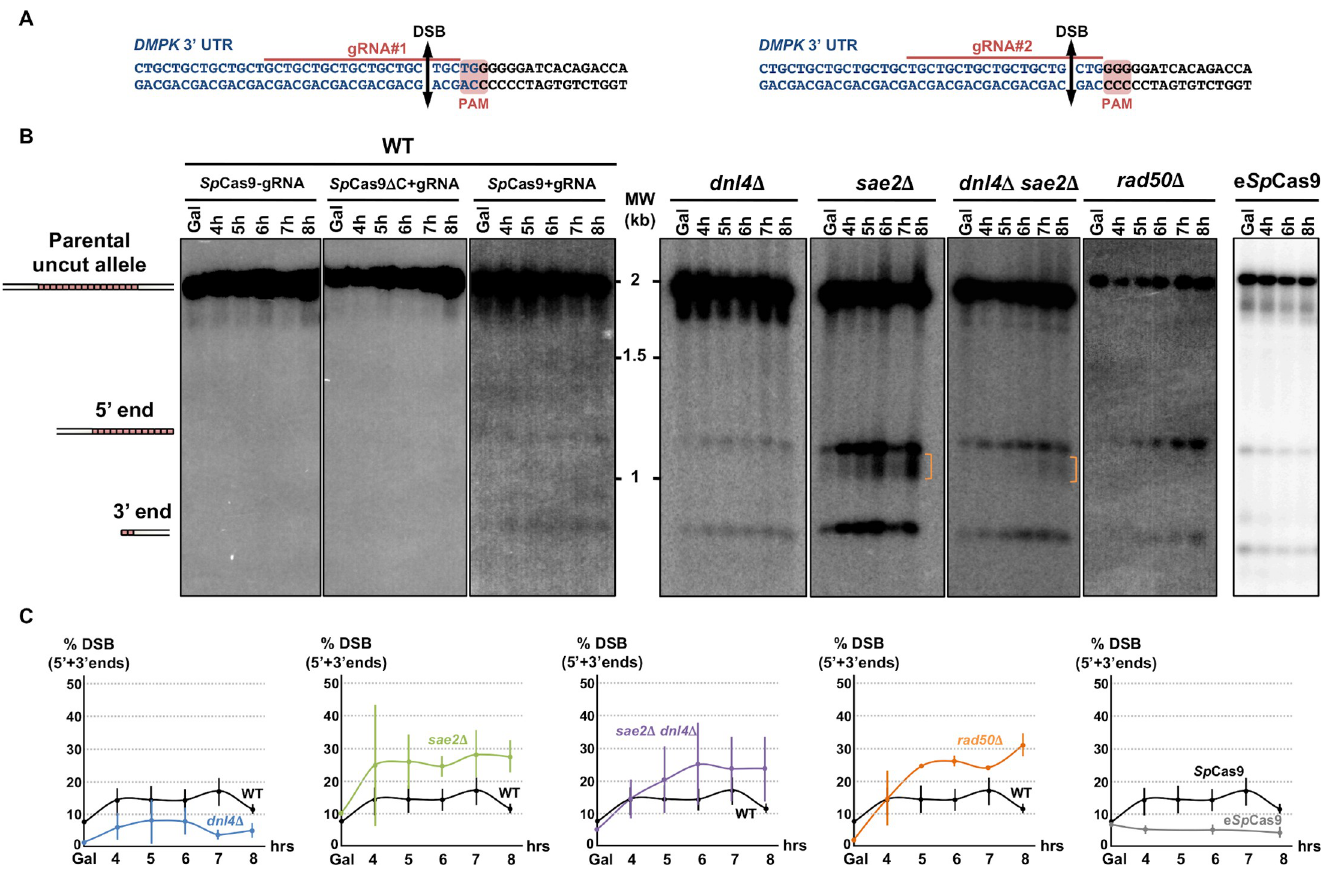
Fig 1. Sp Cas9 and e Sp Cas9 DSB induction in wild type and mutant strains. A: Sequence of the SUP4 ::(CTG)n locus. The CTG trinucleotide repeat tract comes from a human DM1 patient and is shown in blue. The flanking non-repeated DNA is in black. For each guide RNA, the PAM, the gRNA sequence as well as the expected DSB site are indicated. B : Southern blots of yeast strains during time courses. Lanes labeled Sp Cas9-gRNA and Sp Cas9 Δ Cter+gRNA are control strains in which no DSB was visible. In the strain expressing both Sp Cas9 and the gRNA, two bands are visible in addition to the parental allele (1966 bp). One band corresponds to the 3’ end of the DSB containing a small number of triplets (821 bp), the other one corresponds to the 5’ end of the DSB containing most of the repeat tract (1145 bp). C: Quantification of 5’ and 3’ DSB signals. For each time points, the total 5’ + 3’ signals were quantified and plotted as a ratio of the total signal in the lane. Three independent time courses were run in each strain background (except rad50 Δ and e Sp Cas9 for which two time courses were run) and plots show the average of three (or two) time courses. Error bars are 95% confidence intervals.